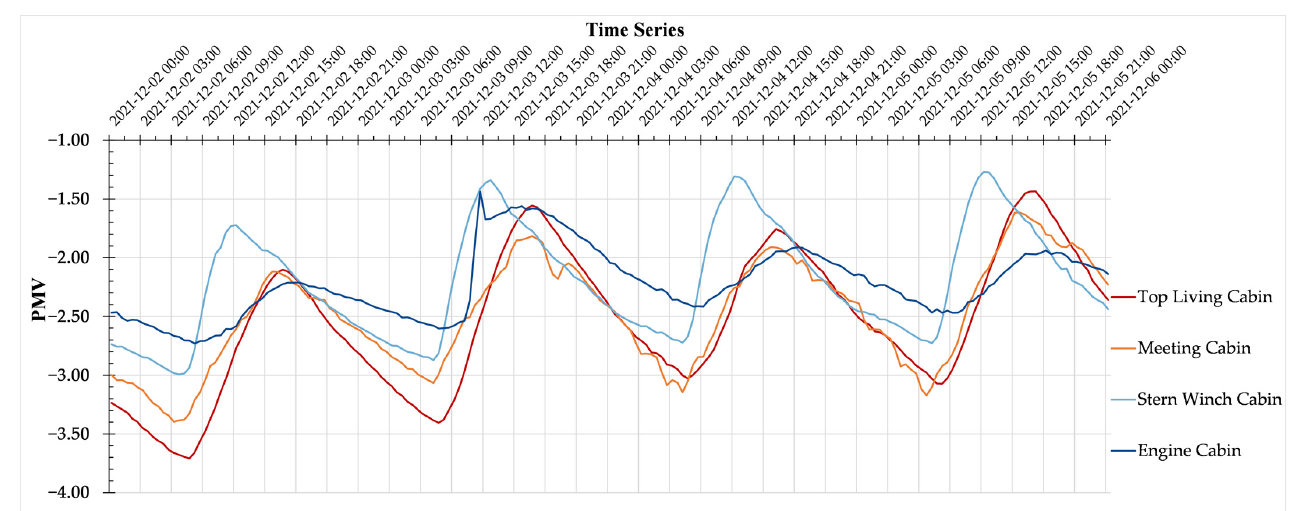
Figure 17. Predicted mean vote in the ship between 2 and 5 December 2021.